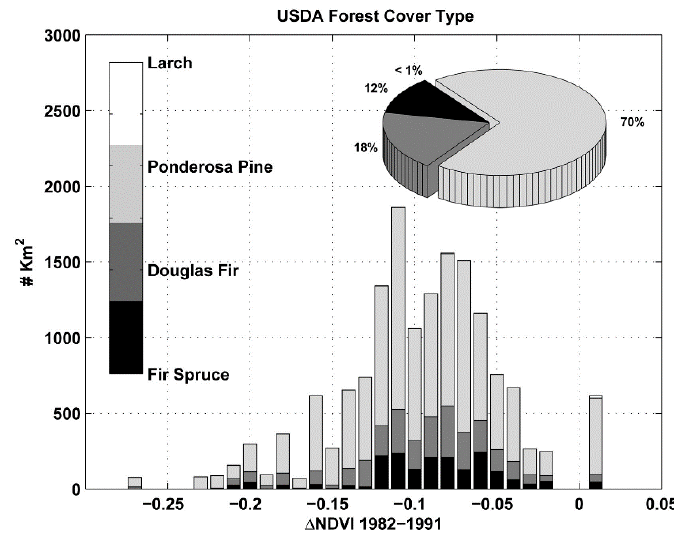
Figure 7. ( A ) Stacked histogram of forest type distribution by negative AVHRR anomaly rescaled to 1 × 1 km, with an inset pie chart of the distribution of forest cover type with an AVHRR anomaly of less than −